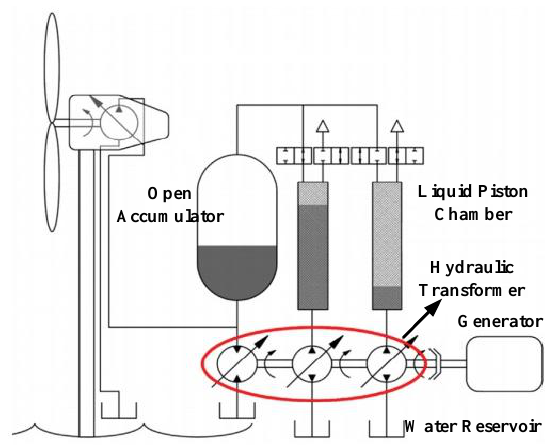
Figure 16. Schematic of CAES system for offshore wind energy storage and generation [70].